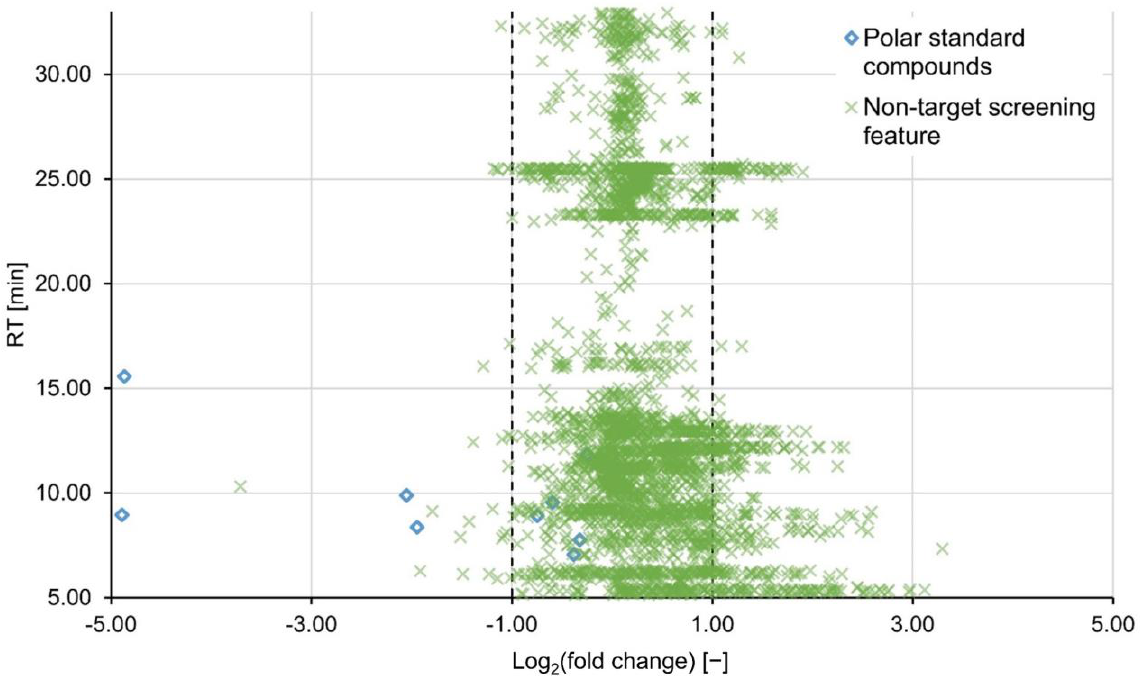
Figure 2. Non-target features (green crosses) and polar standard compounds (blue diamonds) are plotted by their base-2 logarithmic fold changes and RT. The dashed lines mark the consistency interval. Log 2 (fc) values < − 1 and >1 are defined as a decrease and increase in signal intensity, respectively. Here, the sample treated with 30 mg L −1 of PAC H121 was compared to the untreated blank sample, both measured in the positive ionization mode.